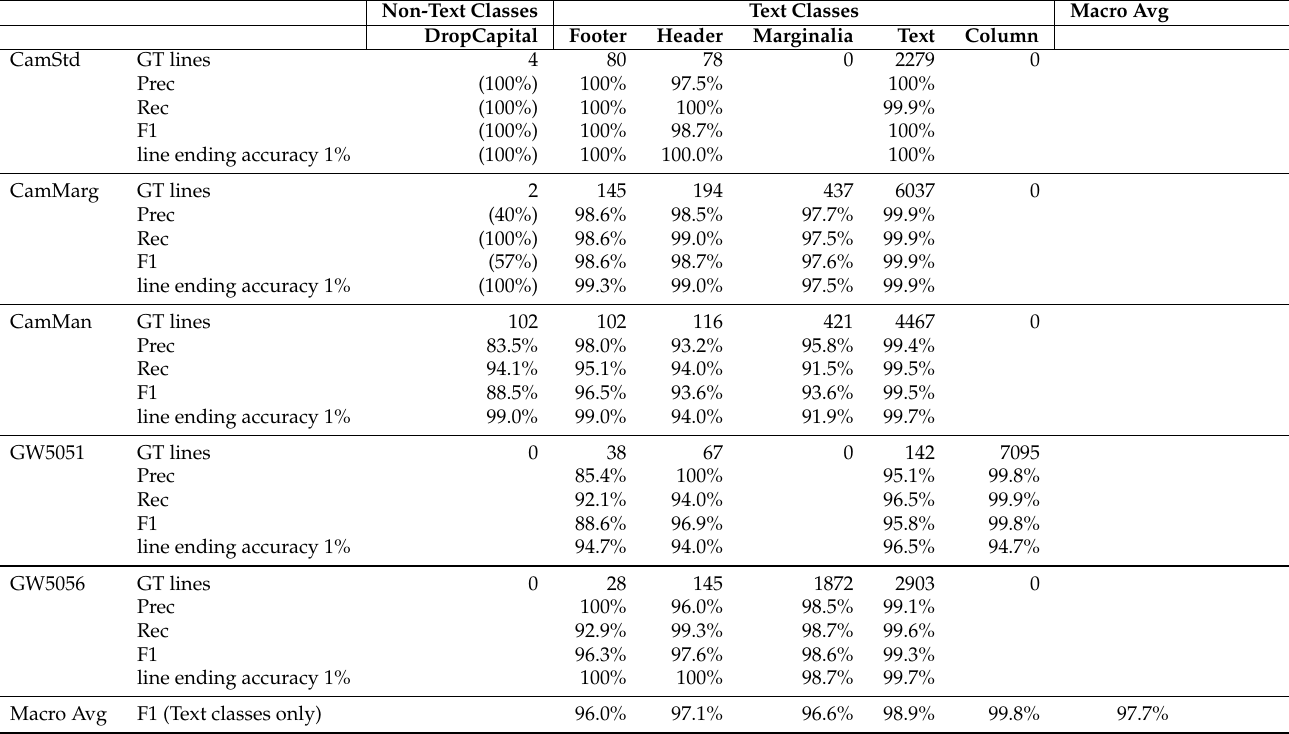
Table 4. Evaluation results of our method on our evaluation datasets. CamStd, CamMarg, and CamManual were evaluated with the default configuration. The results for GW5051 were obtained using the following settings: “no dropped capitals, no marginalia, two-column layout, split top line in headline and header”. The results for GW5056 were obtained using the following settings: “no dropped capitals”. The precision, recall, and F1 are given for each class following our evaluation scheme. In addition, the macro average F1-score was calculated for each text class across all datasets and then macro averaged to achieve a macro average F1-score for all text classes. Results shown in brackets are not representative, as the sample size was too